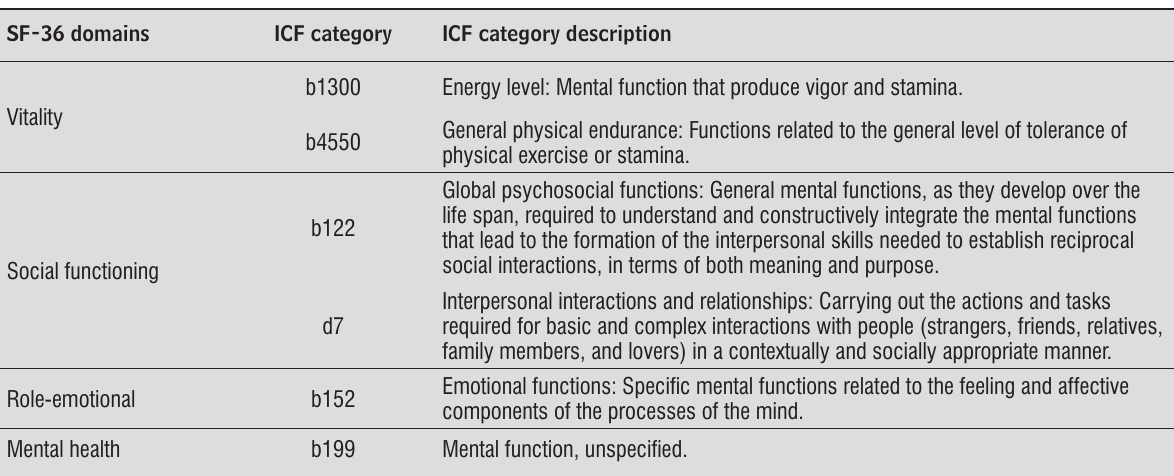
Table 2 - Proposed relationship between SF-36 domains and ICF categories